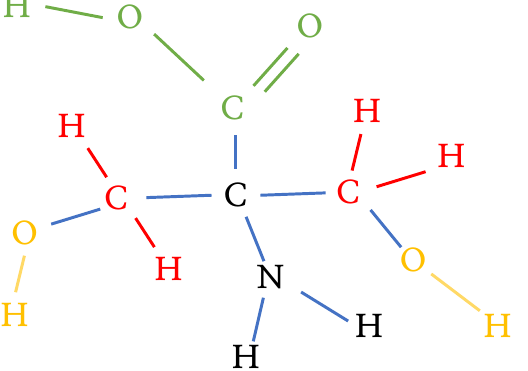
Figure 9. Subtracted groups of